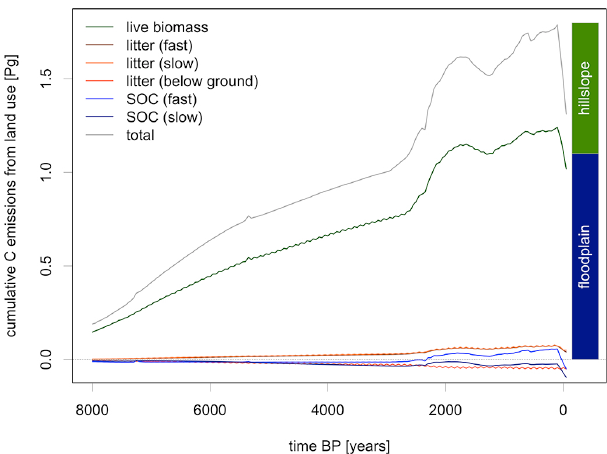
Figure 4. Cumulative carbon emissions as a result of anthropogenic land cover change in the non-alpine Rhine Basin. Emissions were calculated using the LPJ Dynamic Global Vegetation Model in the standard simulation using the KK10 anthropogenic land cover change described in Kaplan et al. (2011, 2012). Emissions accu- mulated steadily as a result of anthropogenic deforestation through- out most of the Holocene, with accelerated deforestation occurring during the Iron Age and Roman period around 500BC–AD500, followed by a period of land abandonment during the Migration Period, and accelerating deforestation during Medieval times. The period AD1500–1900 is marked by relative stability in land use with little new deforestation emissions; during the 20th century land abandonment and a ff orestation lead to a strong uptake of car- bon. Hillslope and floodplain storage are taken from Ho ff mann et al. (2013) (compare Fig.